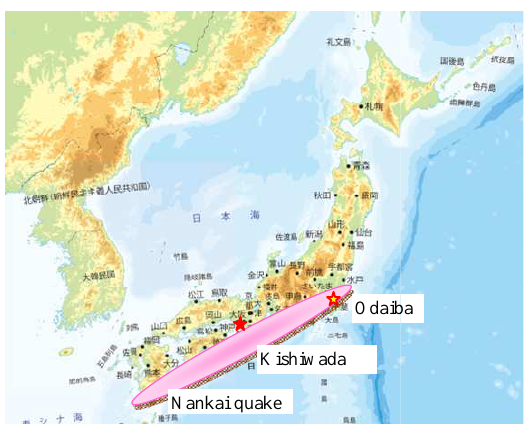
Figure 2. Damage